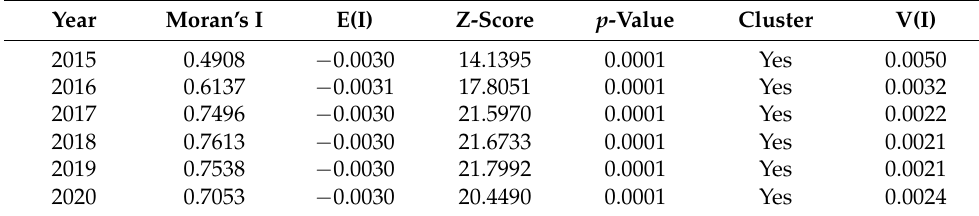
Figure 3. The spatial distribution of the urban O 3 concentration (the 90th percentile of MDA8) in the mainland of China from the years 2015 to 2020. ( a ) 2015; ( b ) 2016; ( c ) 2017; ( d ) 2018; ( e ) 2019; ( f ) 2020. (Note: Urban O 3 concentrations are derived from the average values of the effective monitoring stations in each city). Table 2. Results of spatial autocorrelation analysis of the urban O 3 concentration in mainland